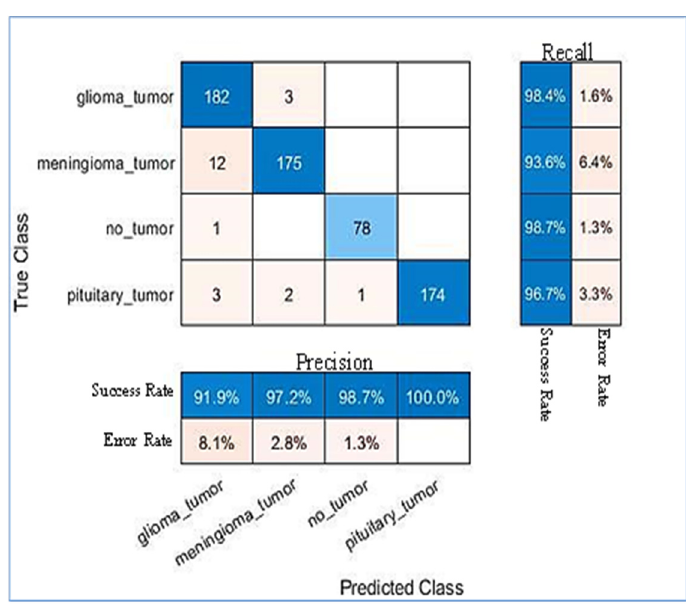
Figure 9. Results of SN-FT